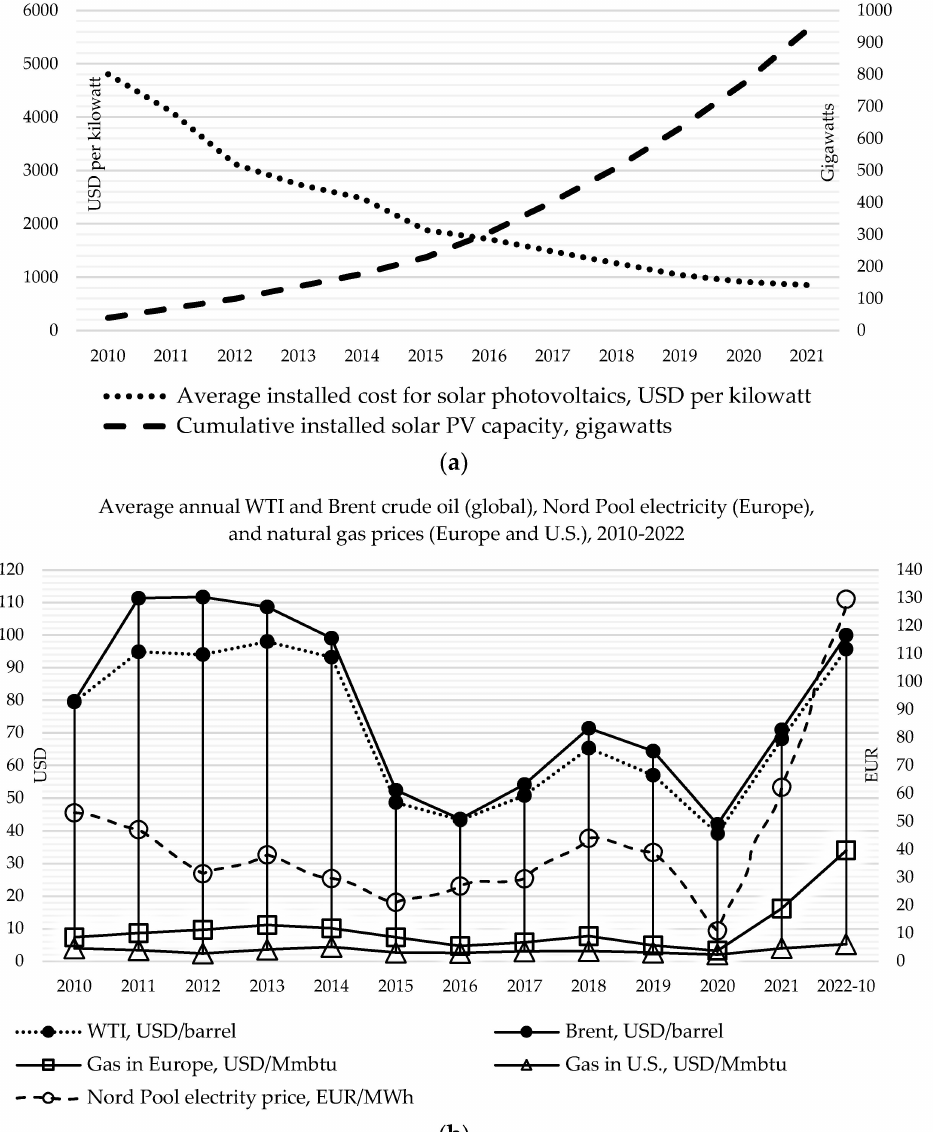
Figure 1. ( a ) Cumulative installed solar PV capacity and average installed cost for solar photovoltaics, worldwide, for the 2010–2021 period (source: author, based on [49,50]); ( b ) average annual WTI and Brent crude oil (global), Nord Pool electricity (Europe), and natural gas prices (Europe and U.S.), for the 2010–2022 period (source: author, based on